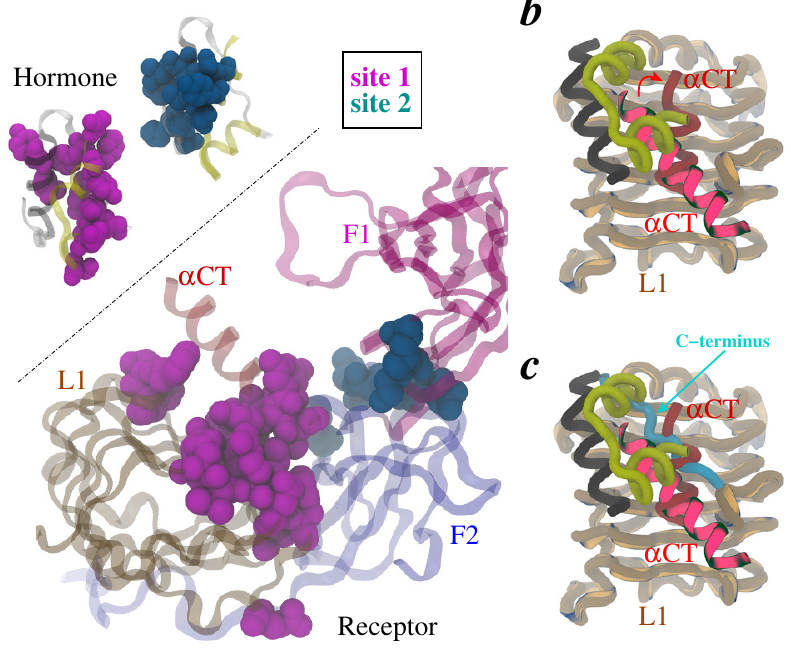
Figure 2. Insulin/IR binding interfaces. ( a ) Patches of residues that form Site 1 (magenta) and Site 2 (dark blue) on hormone and the receptor are shown as space-filling. ( b and c ) Overlay of L1/ α CT conformations in apo-ectodomain (brighter ribbons) and insulin-bound receptor fragment (darker tubes). Both chains of insulin are also rendered (yellow and black tubes). The displacement of α CT is indicated by a red arrow. Panel c in addition shows the steric overlap of the C-terminus of insulin B-chain (cyan tube) in free hormone with α CT position in the hormone-bound structure. The chain/domain coloring and labeling scheme is same as in Figure